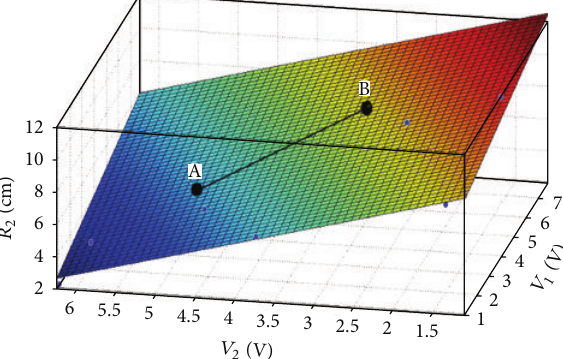
Figure 18: Intersection of two circles to detect impact location.